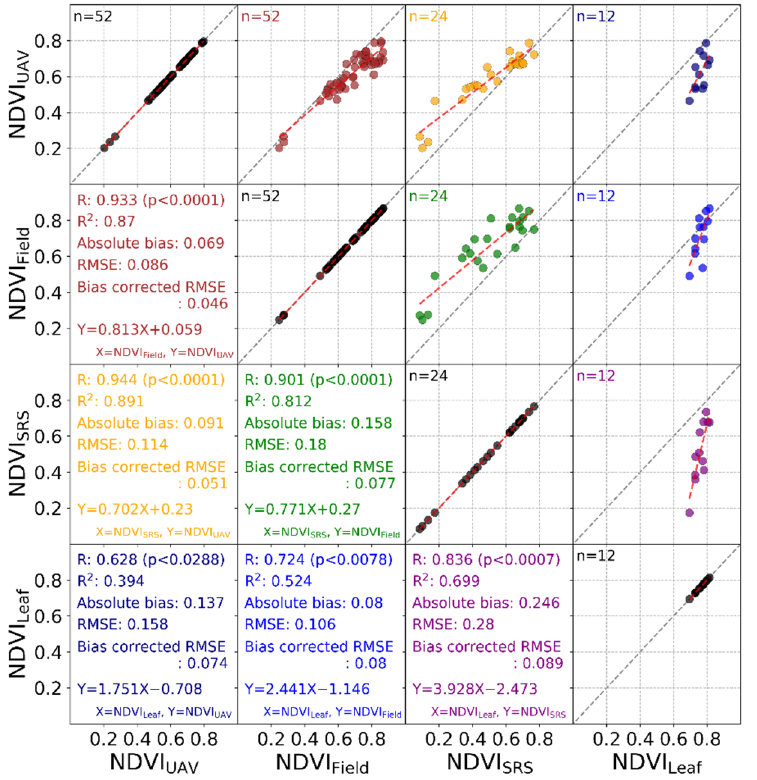
Figure 3. Pair plots for NDVI UAV , NDVI Field , NDVI SRS , and NDVI Leaf . The p -value is < 0.05 for each relationship. RMSE, root mean square error.